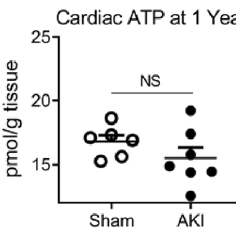
Figure 5. Cardiac ATP levels in females 1 year after AKI or sham procedure. There was no significant difference in Cardiac ATP (n = 6–7).